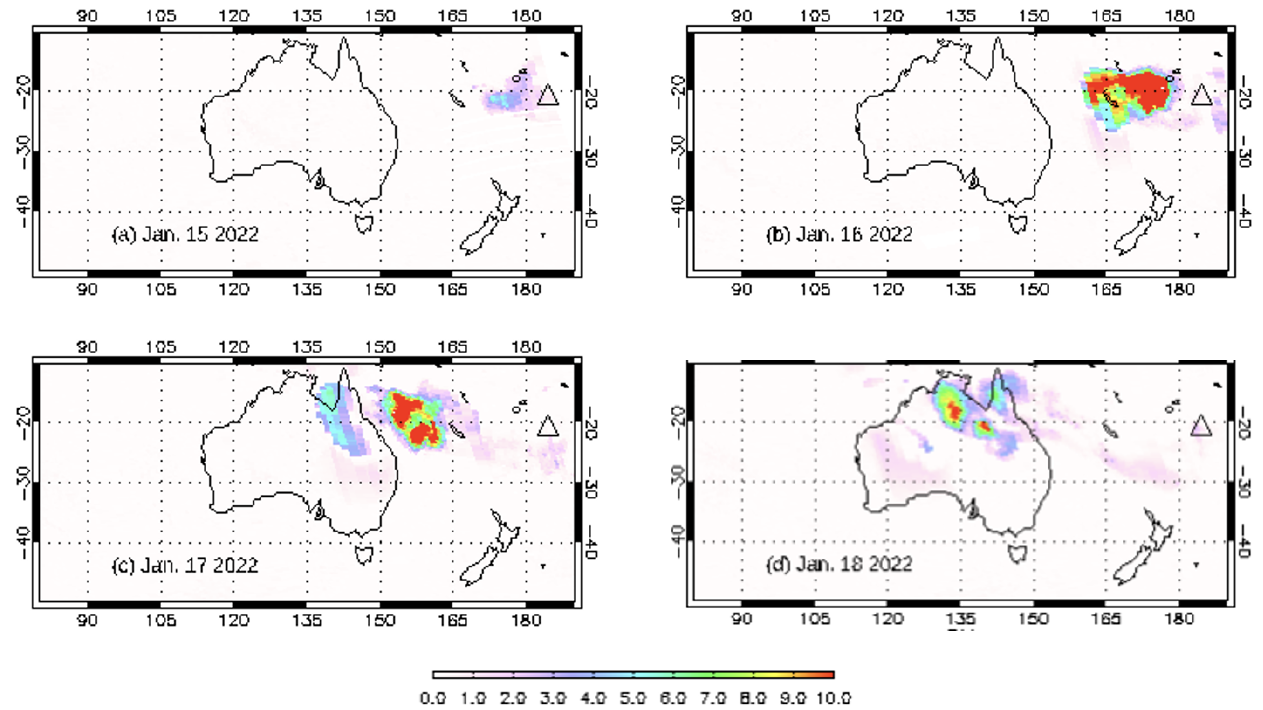
Figure 10. S-NPP OMPS SO 2 STL (Lower Stratospheric) total column products (in Dobson Units), from 15 to 18 January 2022 corresponding to ( a – d ) respectively. The small triangle represents the approximate location of the Hunga-Tonga volcano